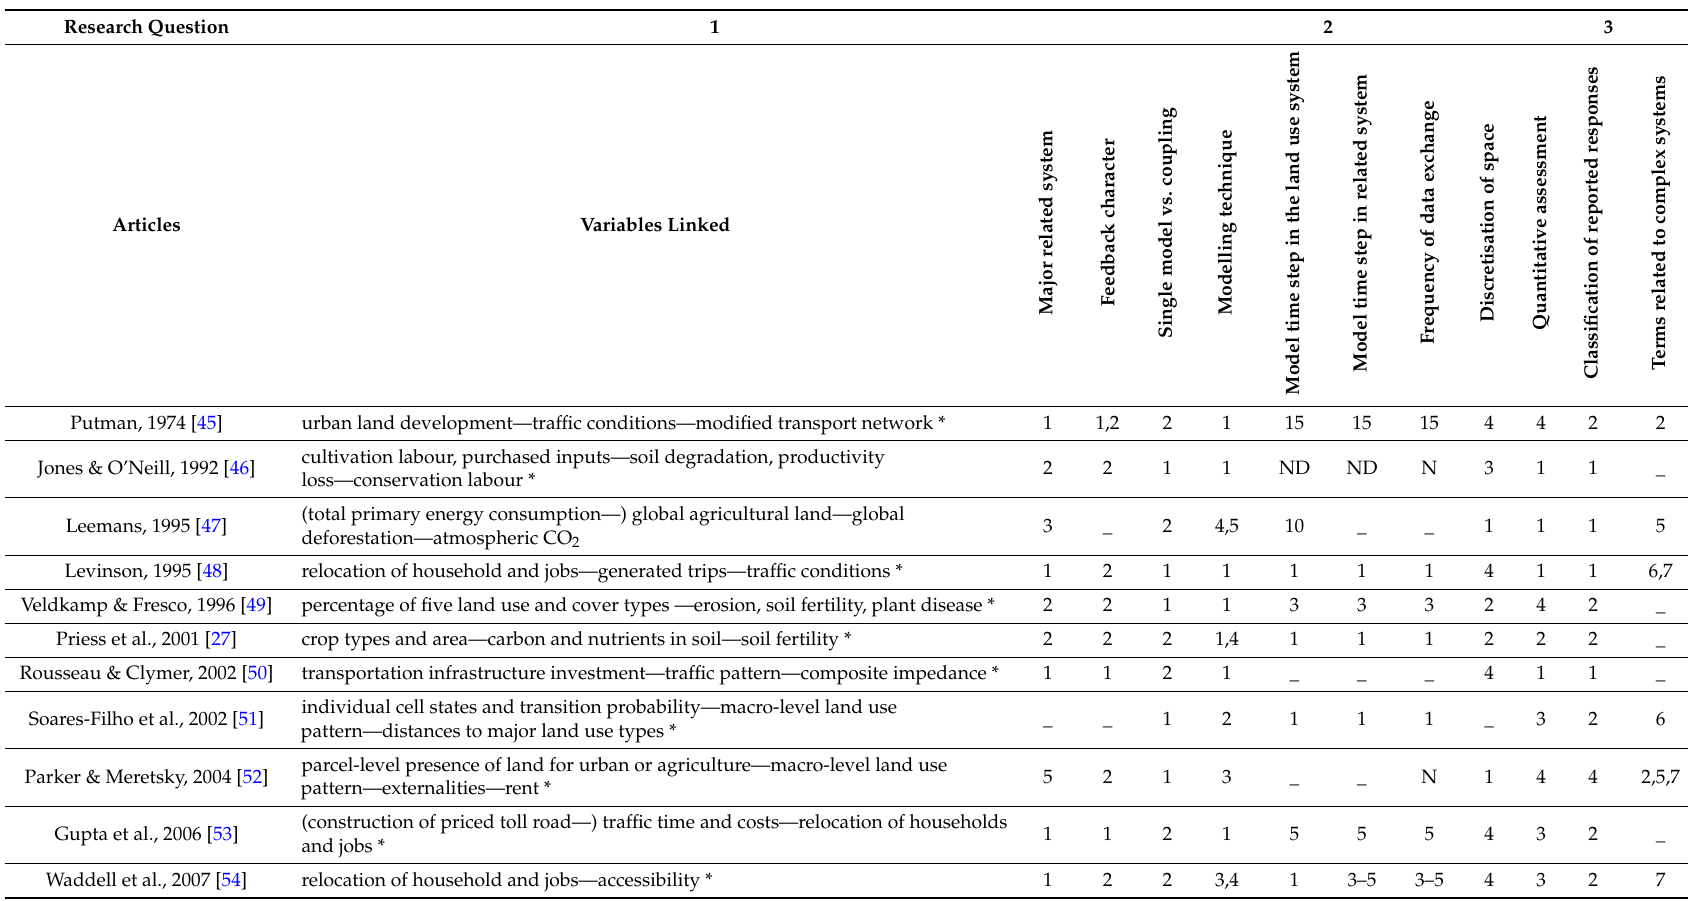
Table 2. Overview of the reviewed articles (1: In cases where feedbacks were only discussed conceptually but not implemented in a computational model, there is no * at the end of the linked variables; 2: External drivers that are not modified by feedbacks are put in parentheses; 3: Explanations of variables and feedbacks are put in squared brackets; 4: ’_’ indicates information not available; ‘N’ indicates not applicable; ‘ND’ indicates not dynamic; 5: Time step and frequency of data exchange expressed in years; 6: For coding references, see Table